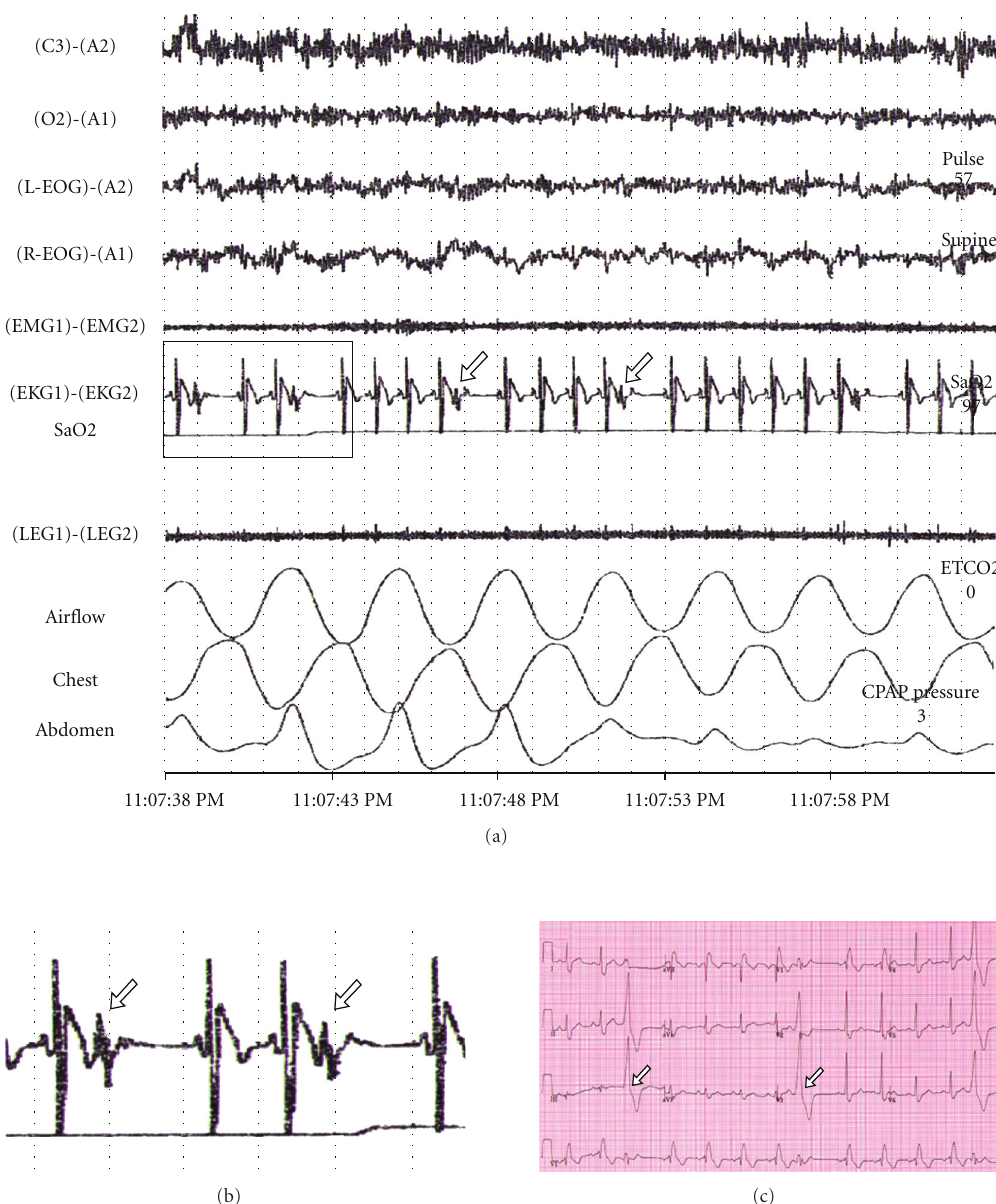
Figure 2: (a) 25 seconds snap shot from sleep study in patient number 2 during wakefulness. White arrows show the beats that were initially reported as non-conducted P-waves. Upper channels (C3-A1) (01-A1): electroencephalogram; third and fourth channel (L-EOG-A1) (R- EOG-A1): oculogram; fifth channel (EMG1) (EMG2): electromyogram; sixth channel (EKG1) (EKG2): electrocardiogram; seventh channel (SaO2): oxygen saturation; eighth channel (LEG1) (LEG2): leg movement; ninth channel: airflow; tenth channel: chest movement; eleventh channel: abdomen movement. (Panel (b)) Amplification of the area under the highlighted rectangle in panel (a). White arrows show the PVCs followed by a post-extrasystolic pause. (Panel (c)) 12-lead ECG shows right bundle branch block. White arrows show PVCs arising probably from the left outflow